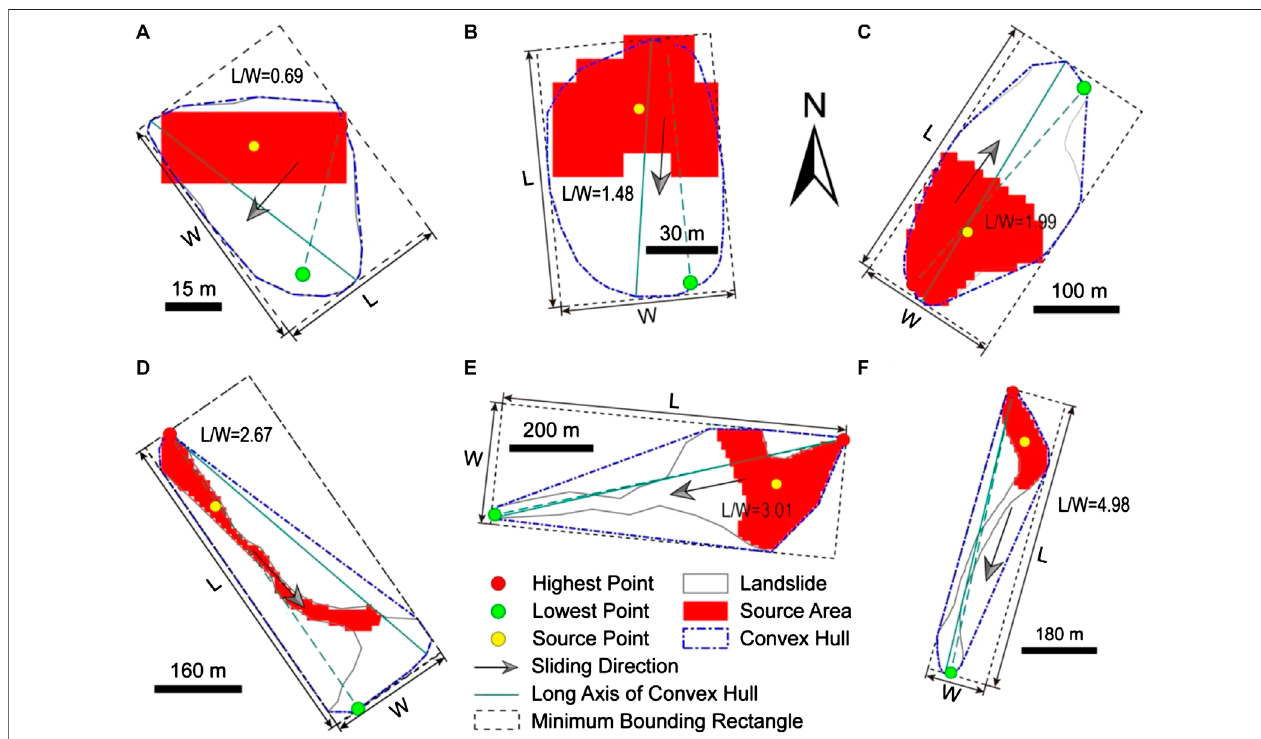
FIGURE 2 | Sketches of landslide length (L) and width (W). Landslide boundaries are real examples selected from the dataset. “ L/W ” is the aspect ratio/length- width ratio.